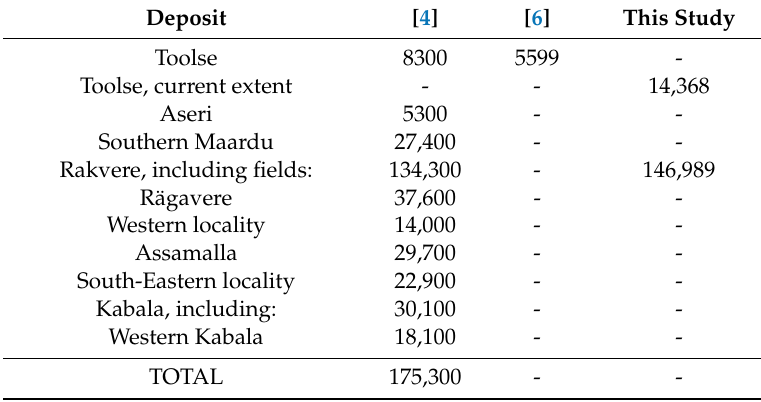
Figure 9. The distribution model of U in the main phosphorite deposit areas based on the historical data.